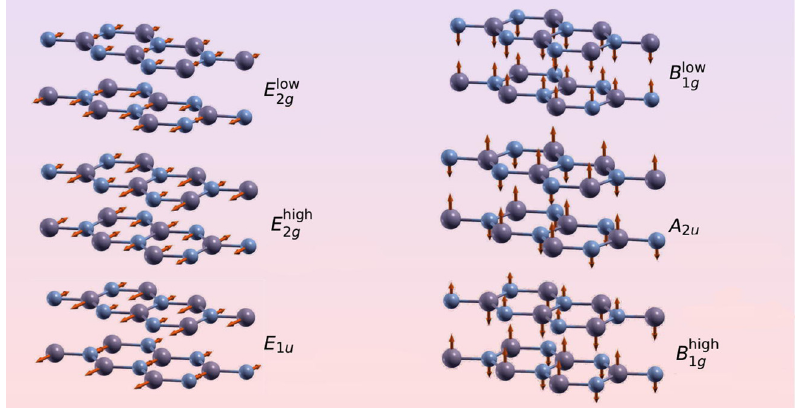
Figure 8: Sketch of the atomic displacement of the nine optical phonons of hBN. E 1u and E 2g modes are